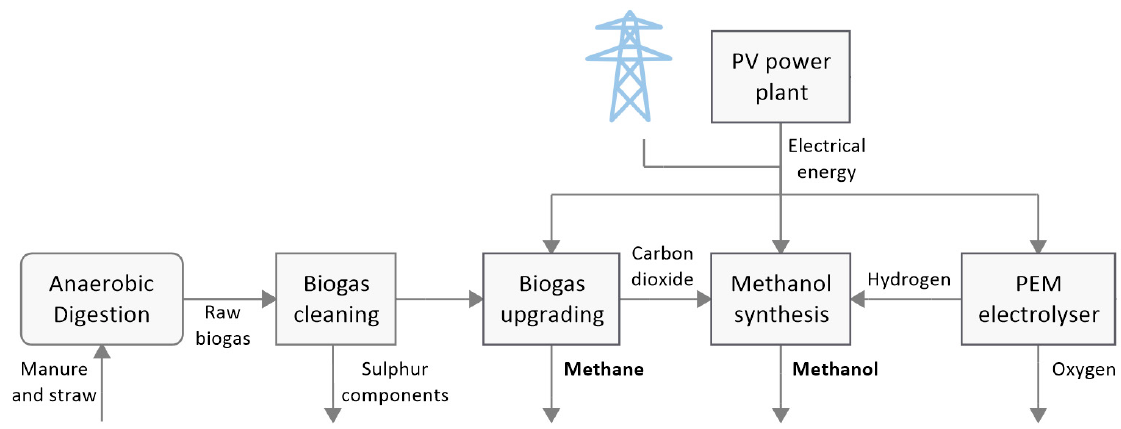
Figure 3. Layout of the hybrid methanol–methane production plant.